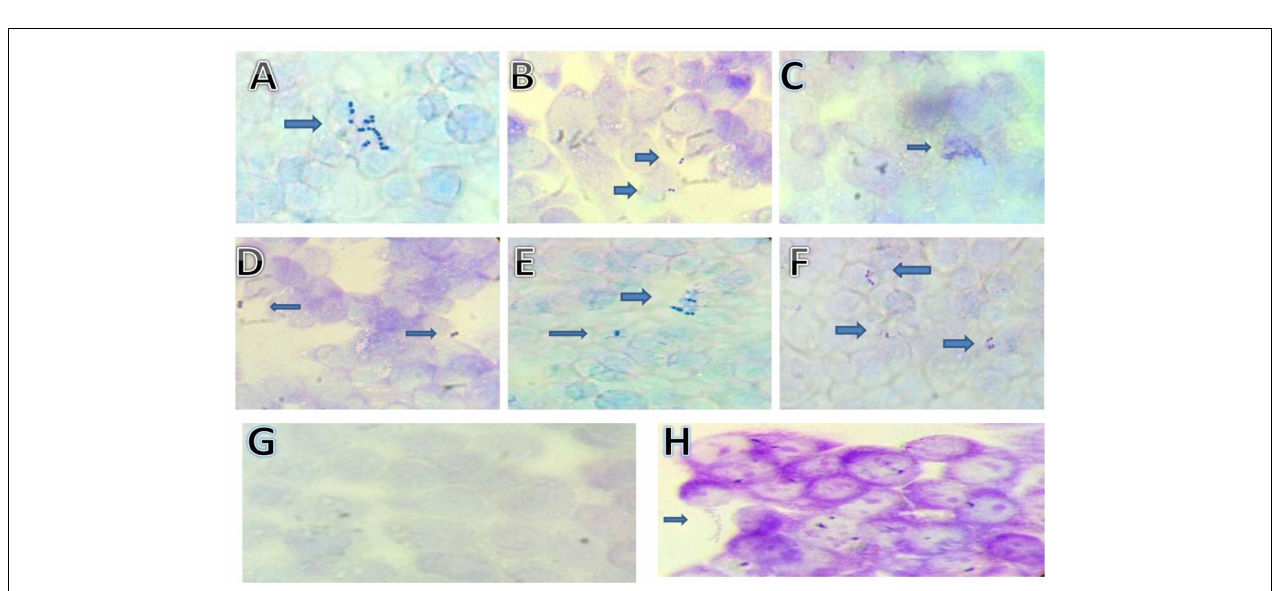
FIGURE 2 | Kinetics of folate production detected in the medium during the growth of S. thermophilus strains. Error bars represent the standard deviation of each mean.